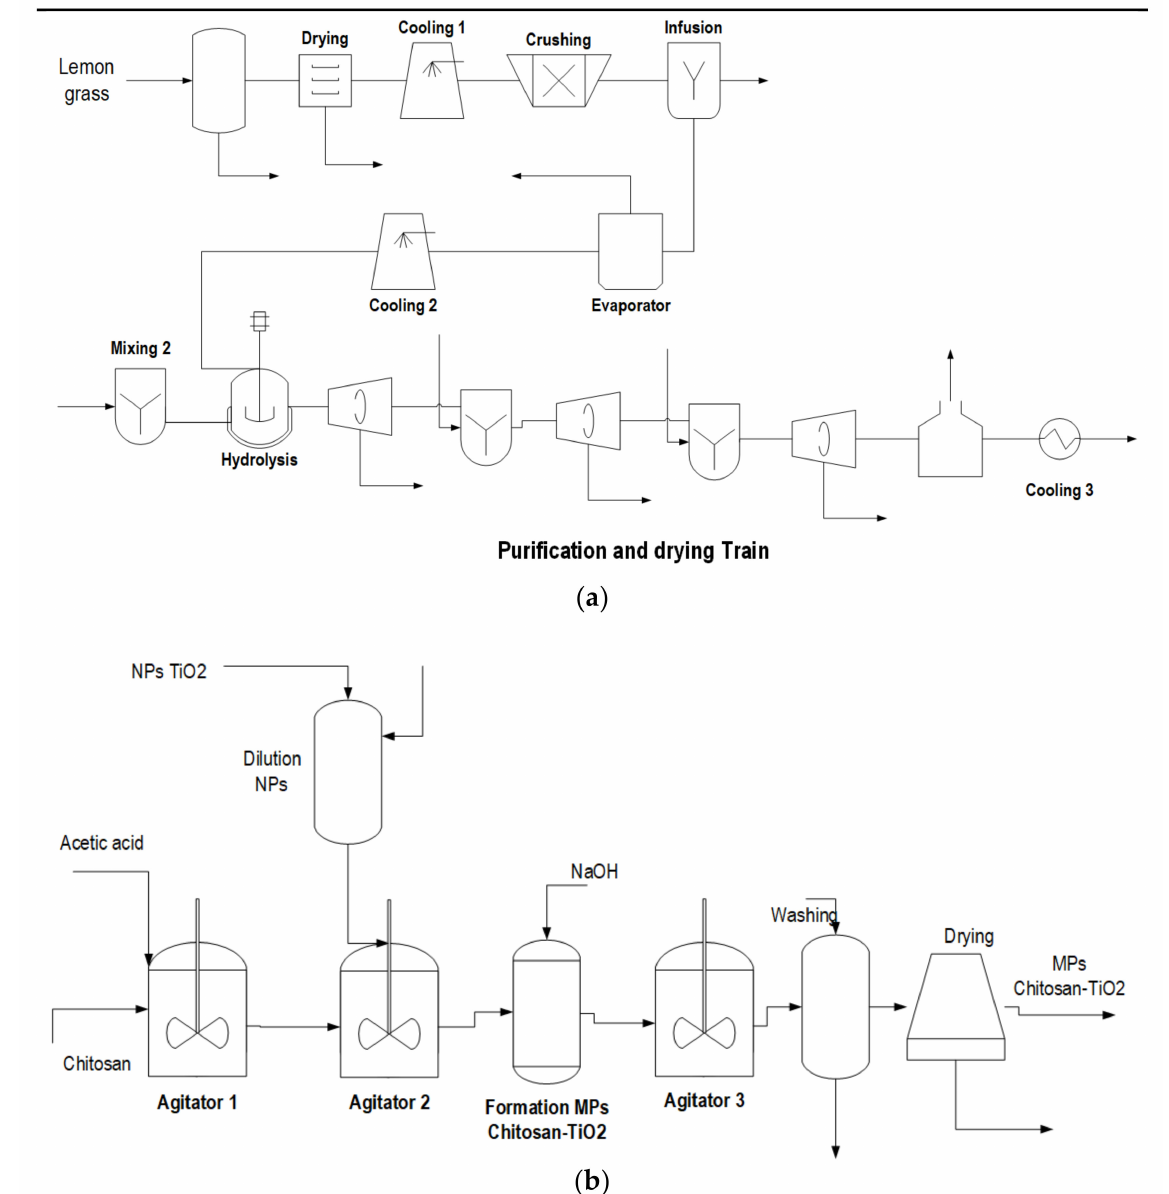
Figure 1. Process diagram of chitosan microbeads modified with TiO 2 nanoparticles production. ( a ) Process stages (1) and (2). ( b ) Process stage